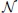
Comparison of the empirical cumulative distribution function and the standard normal one.Cumulative distribution functions of a sampled normal process N
(0,1) (blue line) and of the sampled process ztFR (red line) with a sampling interval of 1 minute (March 4-7, 2013).